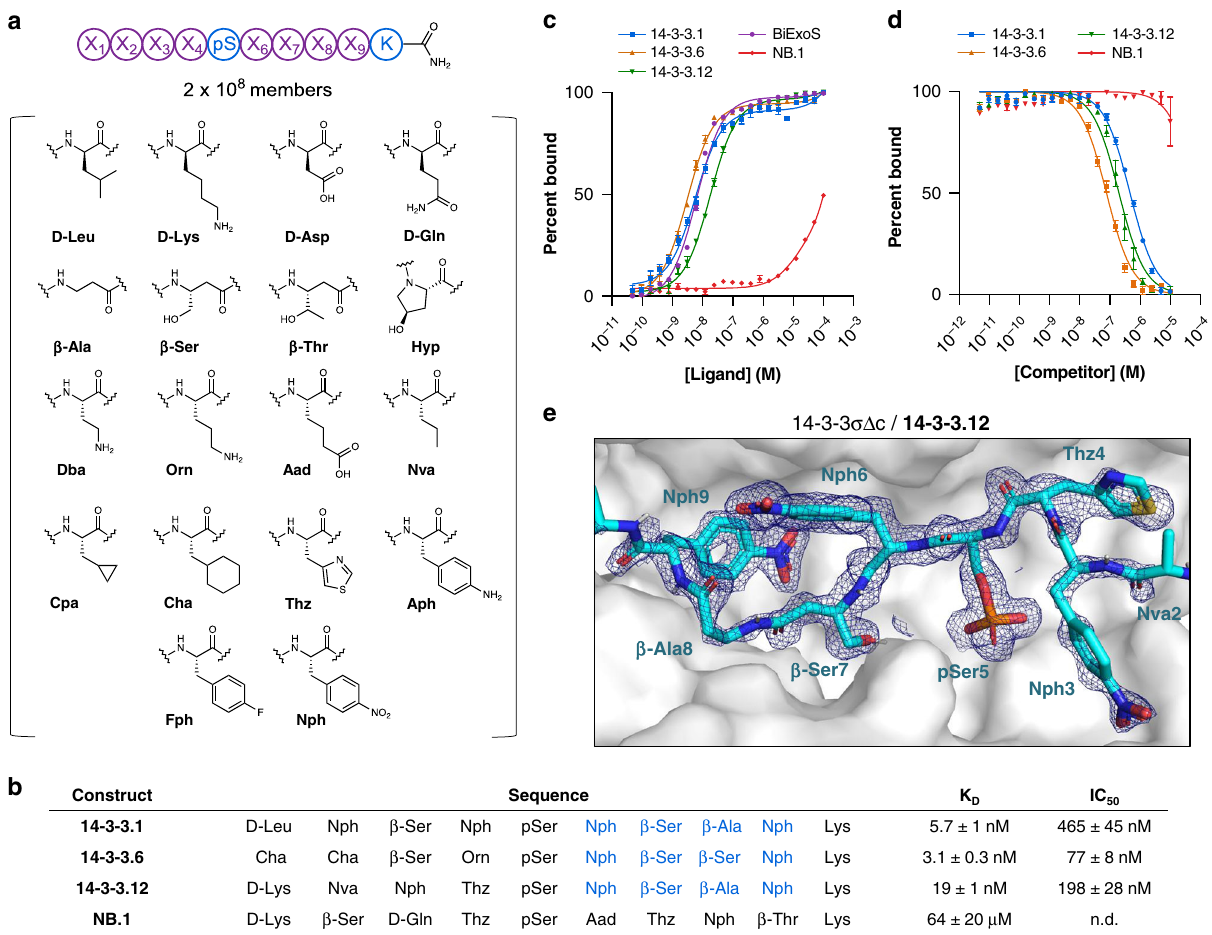
Fig. 5 Synthetic libraries identify a 14-3-3 γ -binding consensus based on β -amino acids. a Design of a non-canonical library used in selections against 14- 3-3 γ . A phosphoserine was fi xed in the middle, fl anked by four varied positions on either side. A suite of non-canonical amino acids was incorporated at each varied position. b Sequences of putative 14-3-3 γ -binding peptides ( 14-3-3.1 , 14-3-3.6 , and 14-3-3.12 ) identi fi ed from af fi nity selections, as well as a negative control peptide (non-binder or NB.1 , identi fi ed as an artifact in selections against 12ca5) chosen for resynthesis and binding validation studies. Residues comprising the conserved C-term motif among 14-3-3 γ binders — Nph- β -Ser-( β -Ala/ β -Ser)-Nph — are indicated in blue. c Identi fi ed binders exhibited nanomolar af fi nities for 14-3-3 γ , as determined by fl uorescence anisotropy of FITC-labeled 14-3-3 γ -binding peptides, NB.1, and a known 14-3-3 γ - binding peptide (BiExoS; positive control). These af fi nities were approximately 10,000-fold higher relative to the negative control. K D values are given in b . Uncertainties correspond to 95% con fi dence intervals derived from nonlinear regression. d Identi fi ed 14-3-3 γ -binders could compete off bound BiExoS in a fl uorescence anisotropy competition assay, suggesting they bind 14-3-3 γ in the canonical, amphipathic binding groove. IC 50 values are given in b . e Molecular structure of 14-3-3 σΔ c (white surface) in complex with 14-3-3.12 (cyan sticks), based on a 1.80 Å crystal structure. The 2Fo-Fc electron density map corresponding to 14-3-3.12 is shown (blue mesh), contoured at 1 σ . Abbreviations: β -Ala β -alanine; β -Ser β -homoserine; β -Thr β -homothreonine; Aad aminoadipic acid; Aph 4-aminophenylalanine; Cha cyclohexylalanine; Cpa cyclopropylalanine; Dba diaminobutyric acid; Fph 4- fl uorophenylalanine; Hyp hydroxyproline; Nph 4-nitrophenylalanine; Nva norvaline; Orn ornithine; pSer phosphoserine; Thz thiazolylalanine. Error bars correspond to standard error among three technical